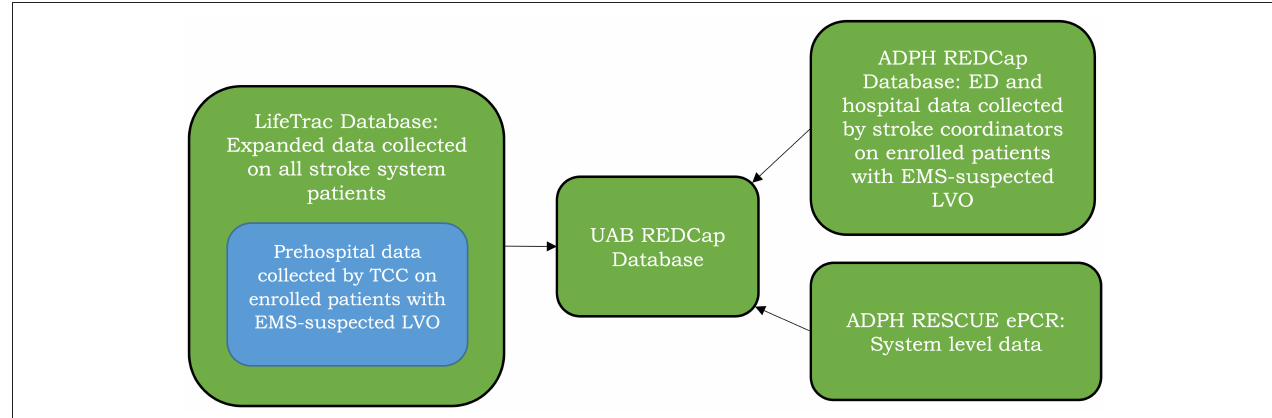
FIGURE 4 | Data sources. (1) Expanded LifeTrac data entry on all stroke system patients with embedded LifeTrac data collection by TCC on study patients to both guide and document the prehospital triage process in real-time; (2) Study patient ED and hospital data entered by stroke coordinators into an ADPH REDCap database, and (3) System level data captured by ADPH’s Recording of Emergency Medical Services Calls and Urgent-care Environment electronic Patient Care Reports (ADPH RESCUE